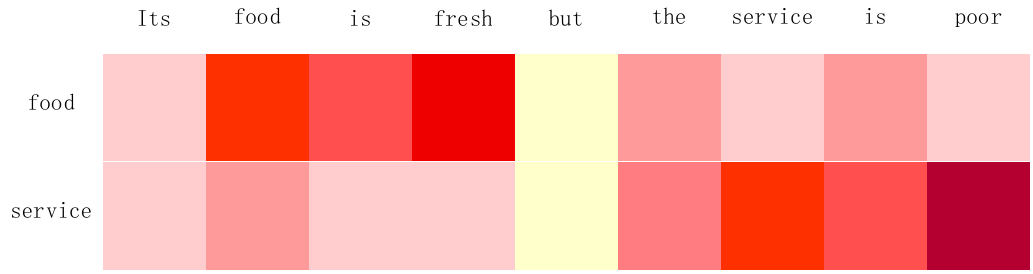
Figure 7. The visualized attention weights for the sentence and aspect term by MIN.